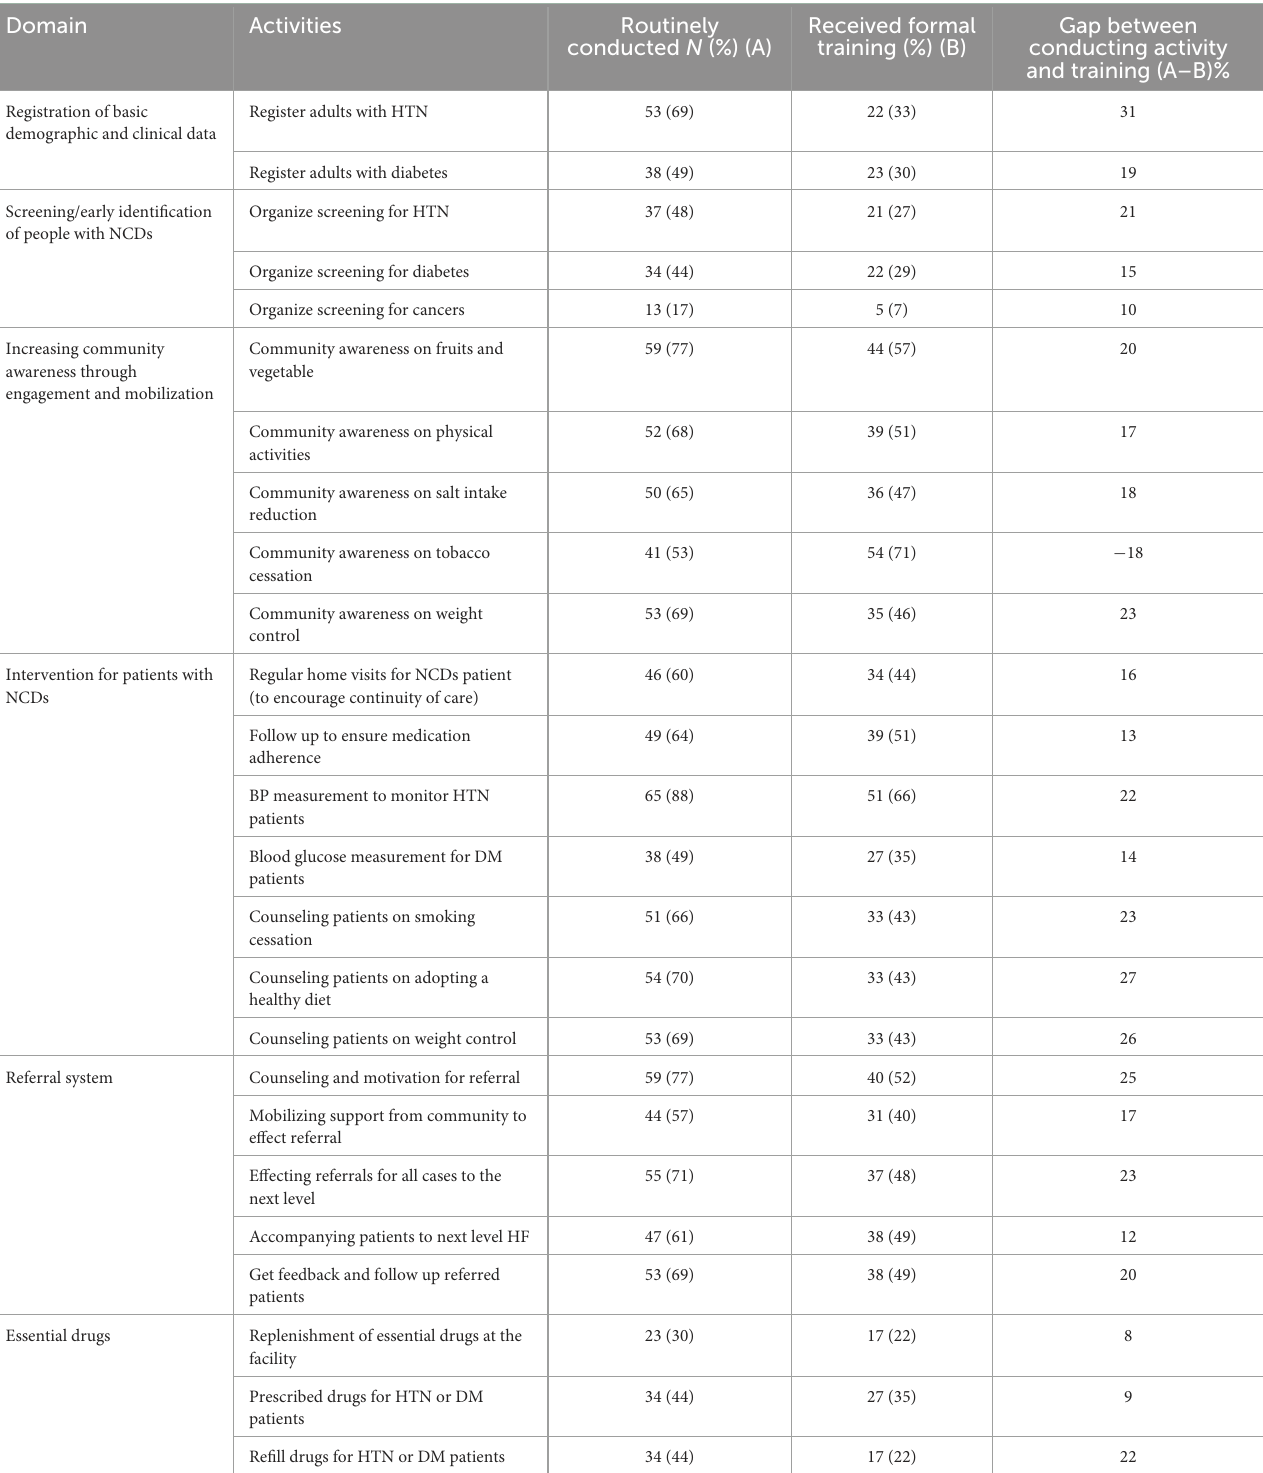
TABLE 2 NCD-related activities carried out by